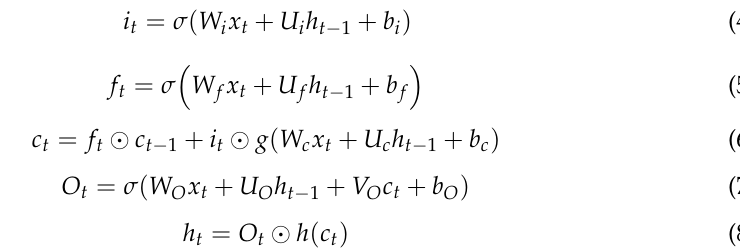
Figure 3. LSTM memory block [70].